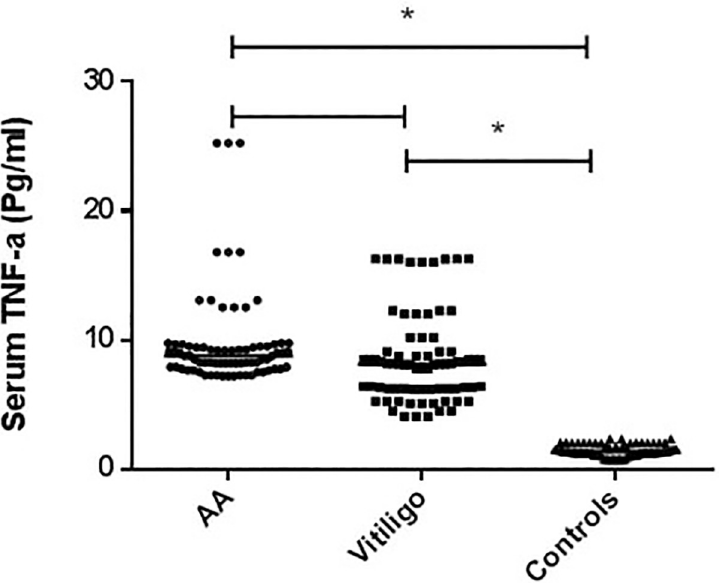
significant ( p < 0.0001), Statistical significance was considered at p value � 0.05. The sTNF- α level, expressed as median (IQR), was 8.8 (7.9–9.5pg/ml), 8.1 (6.3–9.1pg/ml), 1.4 (1.2–1.8pg/ml) in AA, vitiligo and HC groups, respectively. A significantly higher level of sTNF- α in AA and vitiligo patients vs the HCs was